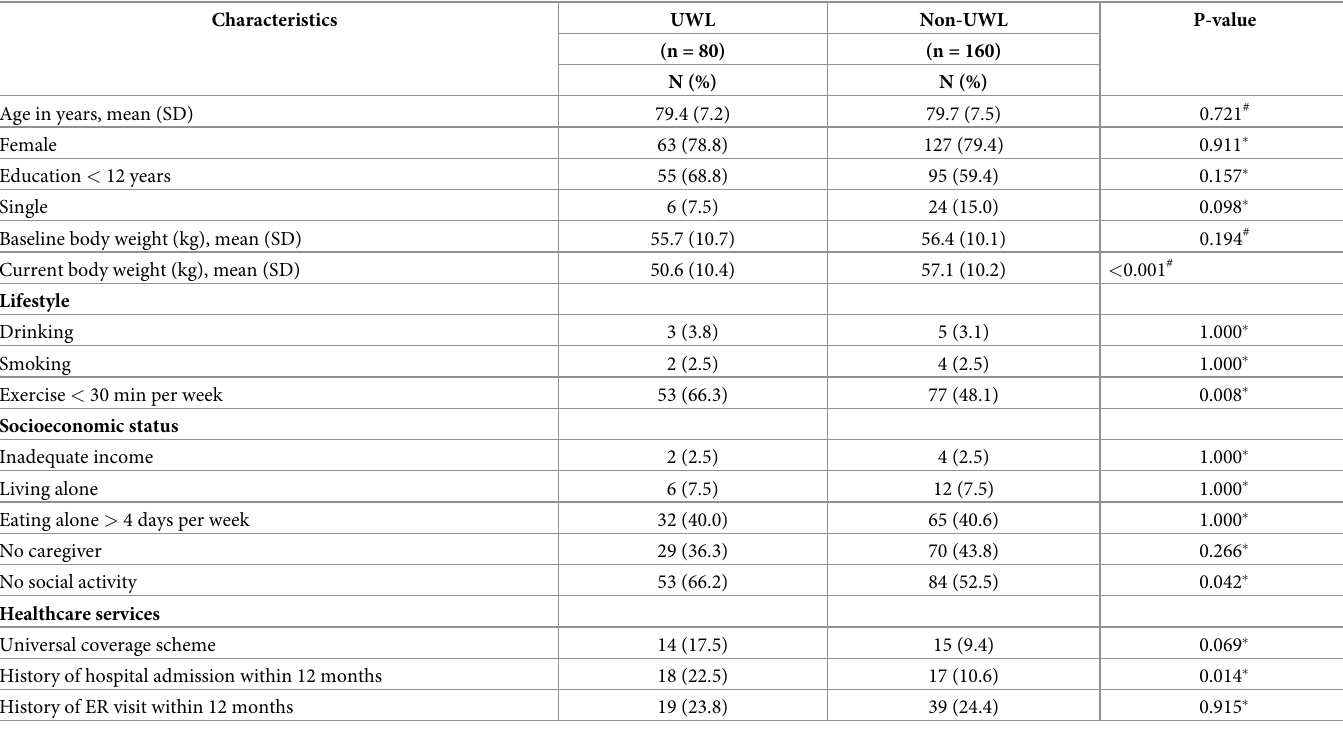
Table 1. Baseline characteristics among older patients in the geriatric outpatient clinic.